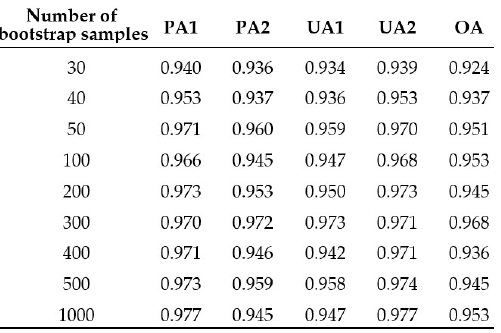
Table 4. Classifier-global-accuracy covering rates of 95% bootstrap-sample confidence intervals with respect to different number of bootstrap samples.